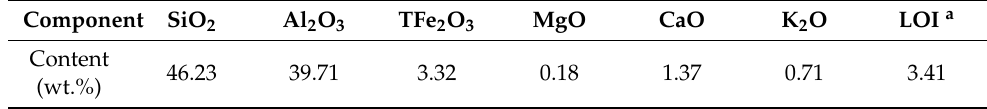
Table 1. Chemical composition of